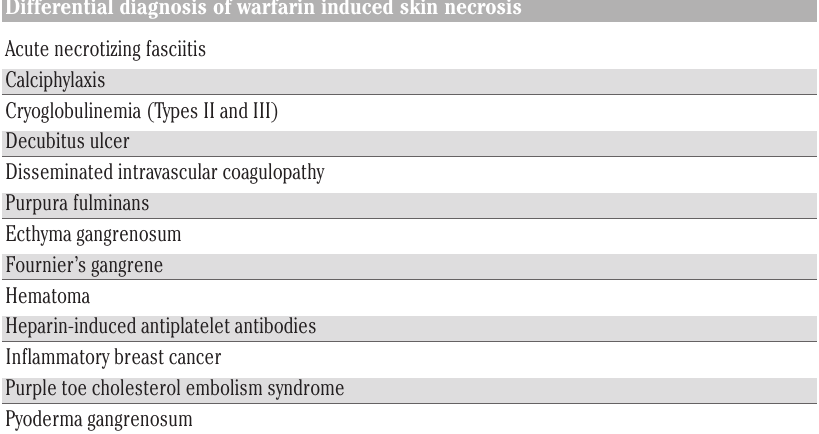
Table 1. Differential diagnosis of warfatin induced skin